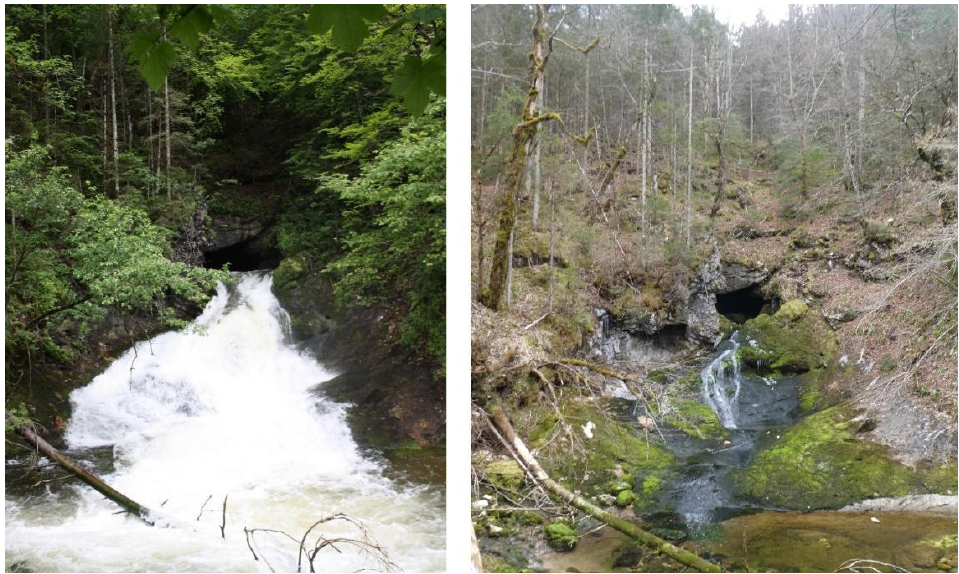
Figure 2. Discharge dynamics at the spring Schwarzbachloch in the Berchtesgaden National Park; the catchment area shows a high degree of karstification.